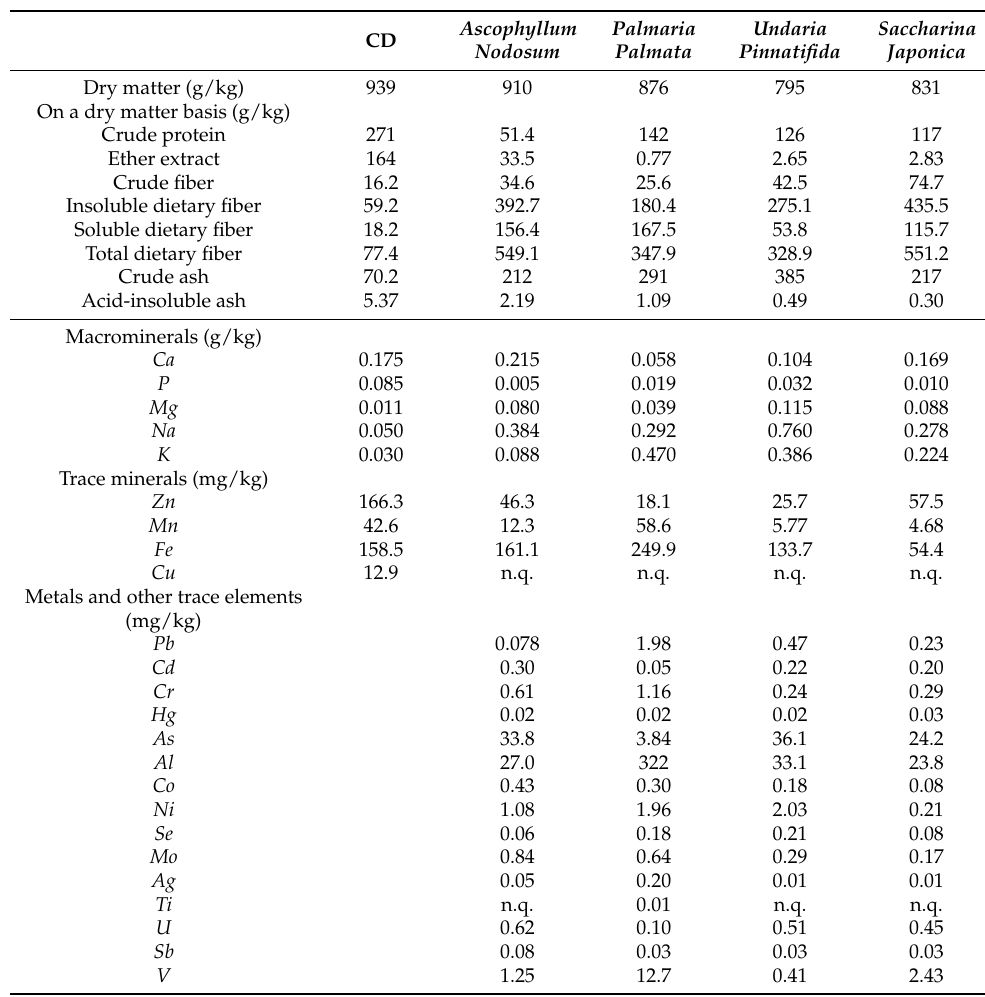
Table 1. Chemical composition of the commercial extruded control diet (CD) and intact seaweeds used as supplements (15 g/kg of as-is diet) during the present